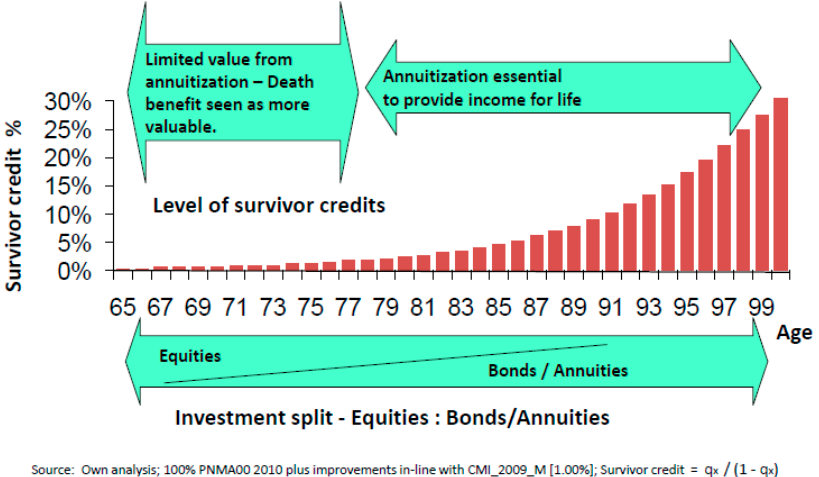
Figure 4. When to